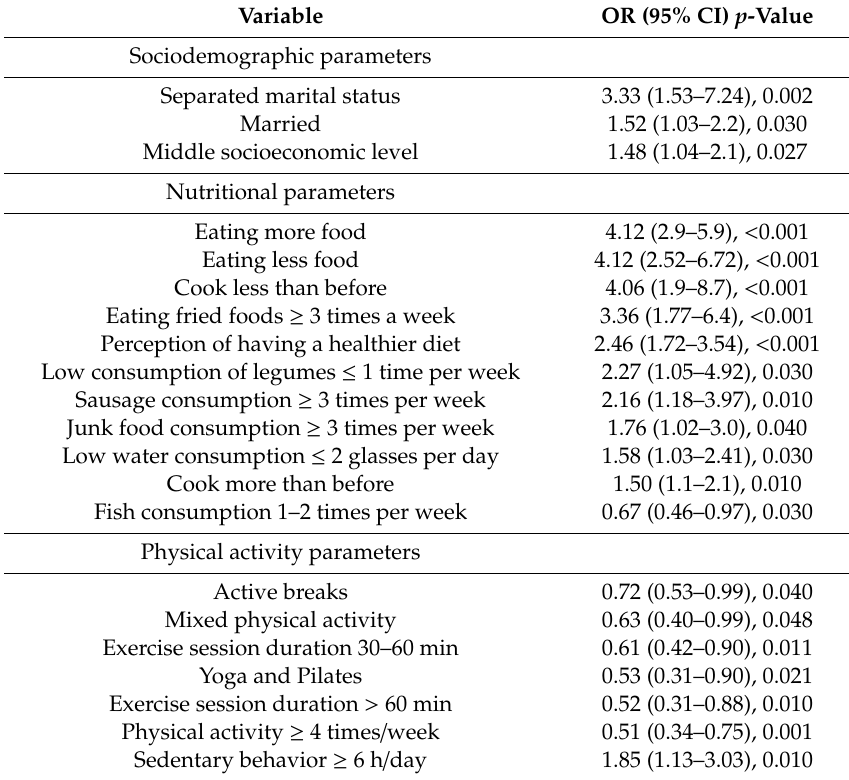
Table 4. Factors related to the body weight increase perception in COVID-19 confinement.